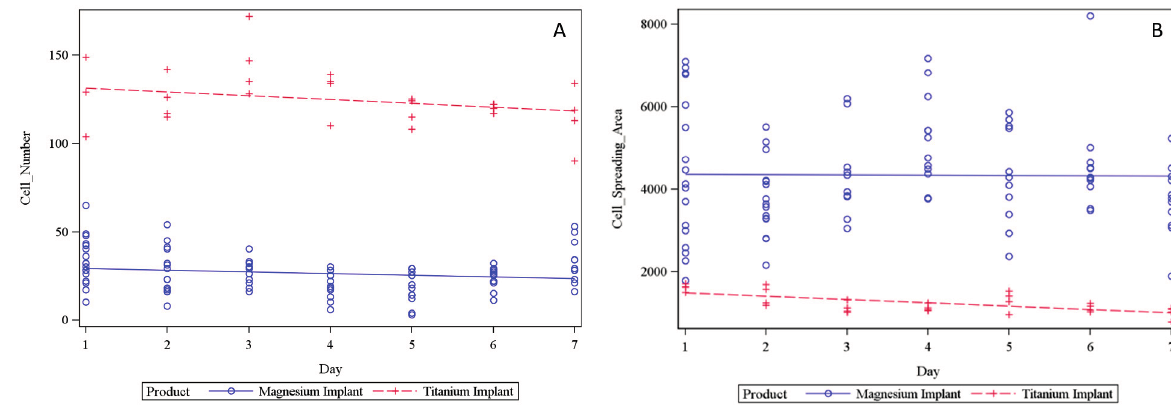
Figure 6. Osteoblasts seeded on titanium and magnesium implant. The cell number development ( A ) and the cell spreading area development ( B ) over seven days were